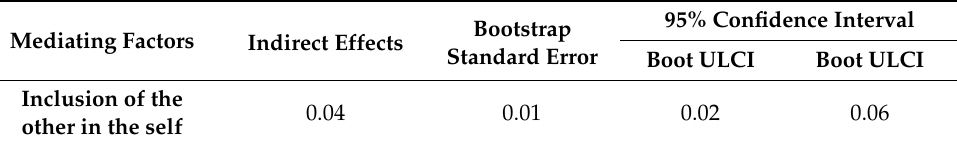
Table 3. Direct Effect between the Experience of Warmth and Intentions toward Prosocial Behavior. Intention to Purchase Eco-Friendly Products β SE t Boot ULCI Boot ULCI Warmth of scent (vs. Cold) 0.10 0.05 2.04 * 0.00 0.21 Need for social connectedness 0.11 0.02 4.22 *** 0.06 0.17